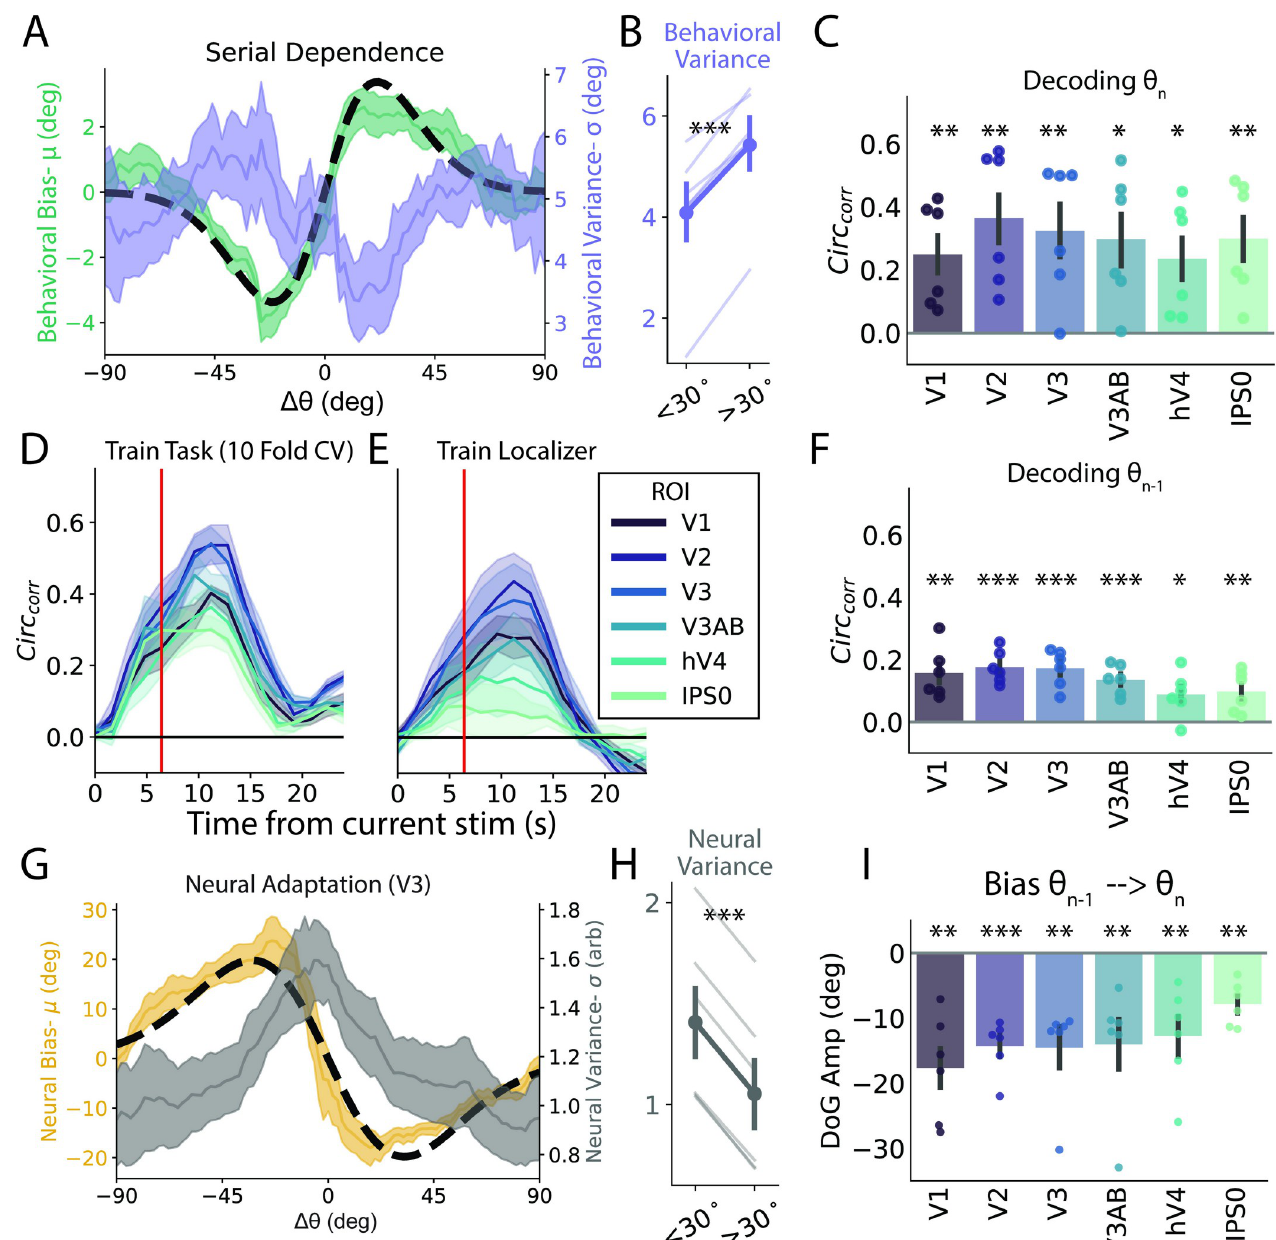
Fig 2. Caption behavioral and neural bias. (A) Left axis, behavioral serial dependence. Shaded green: average model-estimated bias as a function of Δ θ ( ± SEM across participants); dotted black line: average DoG fit to raw participant responses sorted by Δ θ . Right axis, variance. Purple shaded line: model- estimated variance as a function of Δ θ ( ± SEM across participants). (B) Behavioral σ is significantly less for | Δ θ | < 30˚. (C) Decoded orientation was significantly greater than chance when indexed with circular correlation for all ROIs examined. Error bars indicate ± SEM across participants. Dots show data from individual participants. (D) Decoding performance across time for a subset of ROIs. Vertical red line indicates time point used in most analysis. (E) Decoding performance across time for a decoder trained on a separate sensory localization task. (F) Performance of task decoder trained and tested on identity of previous stimulus across all ROIs. (G) Left axis, decoding bias. Shaded yellow line: decoded bias ( μ circ of decoding errors) sorted by Δ θ ( ± SEM across participants); dotted black line: average DoG fit to raw decoding errors sorted by Δ θ . Right axis, decoded σ circ . Shaded gray line: average decoding variance ( σ circ ) as a function of Δ θ ( ± SEM across participants). Note that σ circ can range from [0, inf] and has no units. (H) Decoded variance is significantly greater for | Δ θ | < 30˚. (I) Decoded errors are significantly repulsive when parameterized with a DoG in all ROIs. � , p < 0.05; �� , p < 0.01; ��� , p < 0.001. Data and code supporting this figure found here: https://osf.io/e5xw8/?view_only=e7c1da85aa684cc8830aec8d74afdcb4. DoG, Derivative of Gaussian; ROI, region of interest.